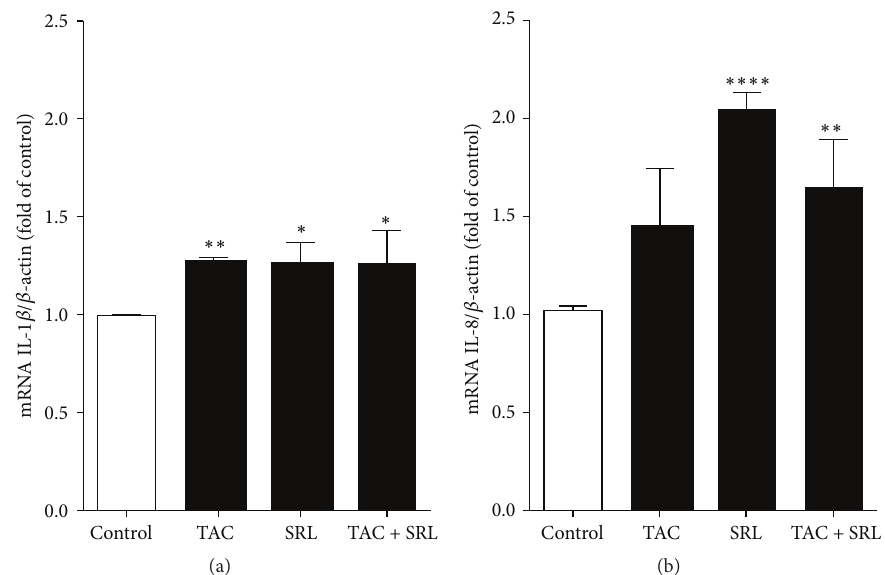
Figure 2: The effect of immunosuppressant drugs on gene expression of IL-1beta and IL-8 in human islets. Human islets cultured without or with tacrolimus (TAC 30 𝜇 g/L), sirolimus (SRL 30 𝜇 g/L), or a combination thereof for 24 hours were tested for gene expression of (a) IL-1beta and (b) IL-8 by qPCR in relation to the control gene 𝛽 -actin. Data are presented as mean ± SEM of four separate experiments from four different donors. ∗ 𝑝 < 0.05 , ∗∗ 𝑝 < 0.005 , and ∗∗∗∗ 𝑝 < 0.0001 versus control.